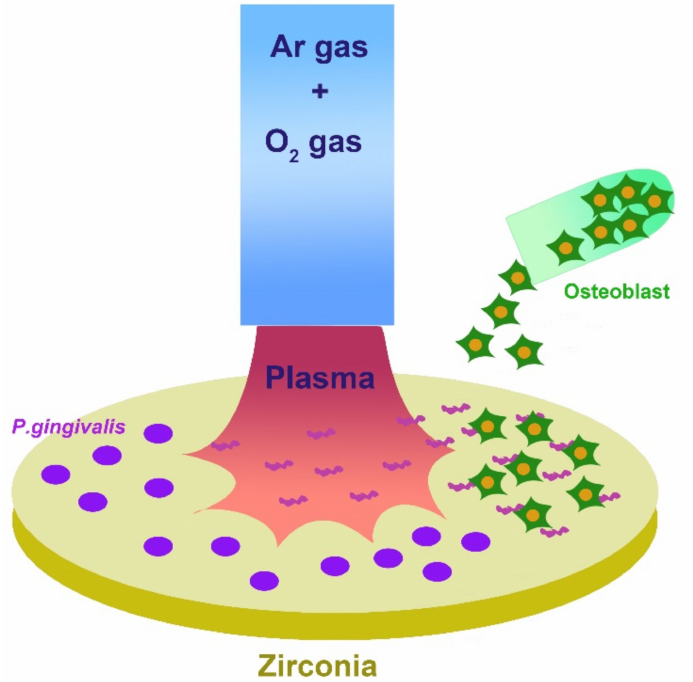
Figure 2. Specimens on which bacteria were cultured and treated with non-thermal